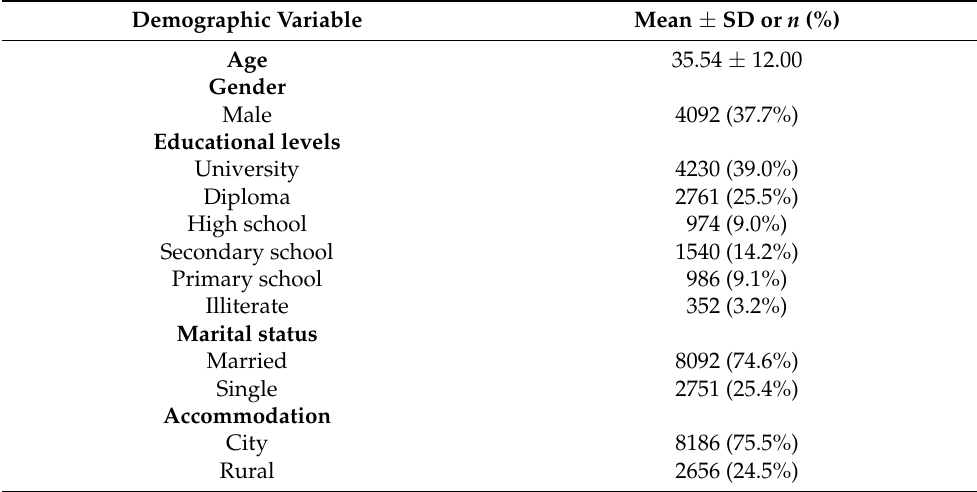
Table 1. The demographic characteristics of the participants included in this study.